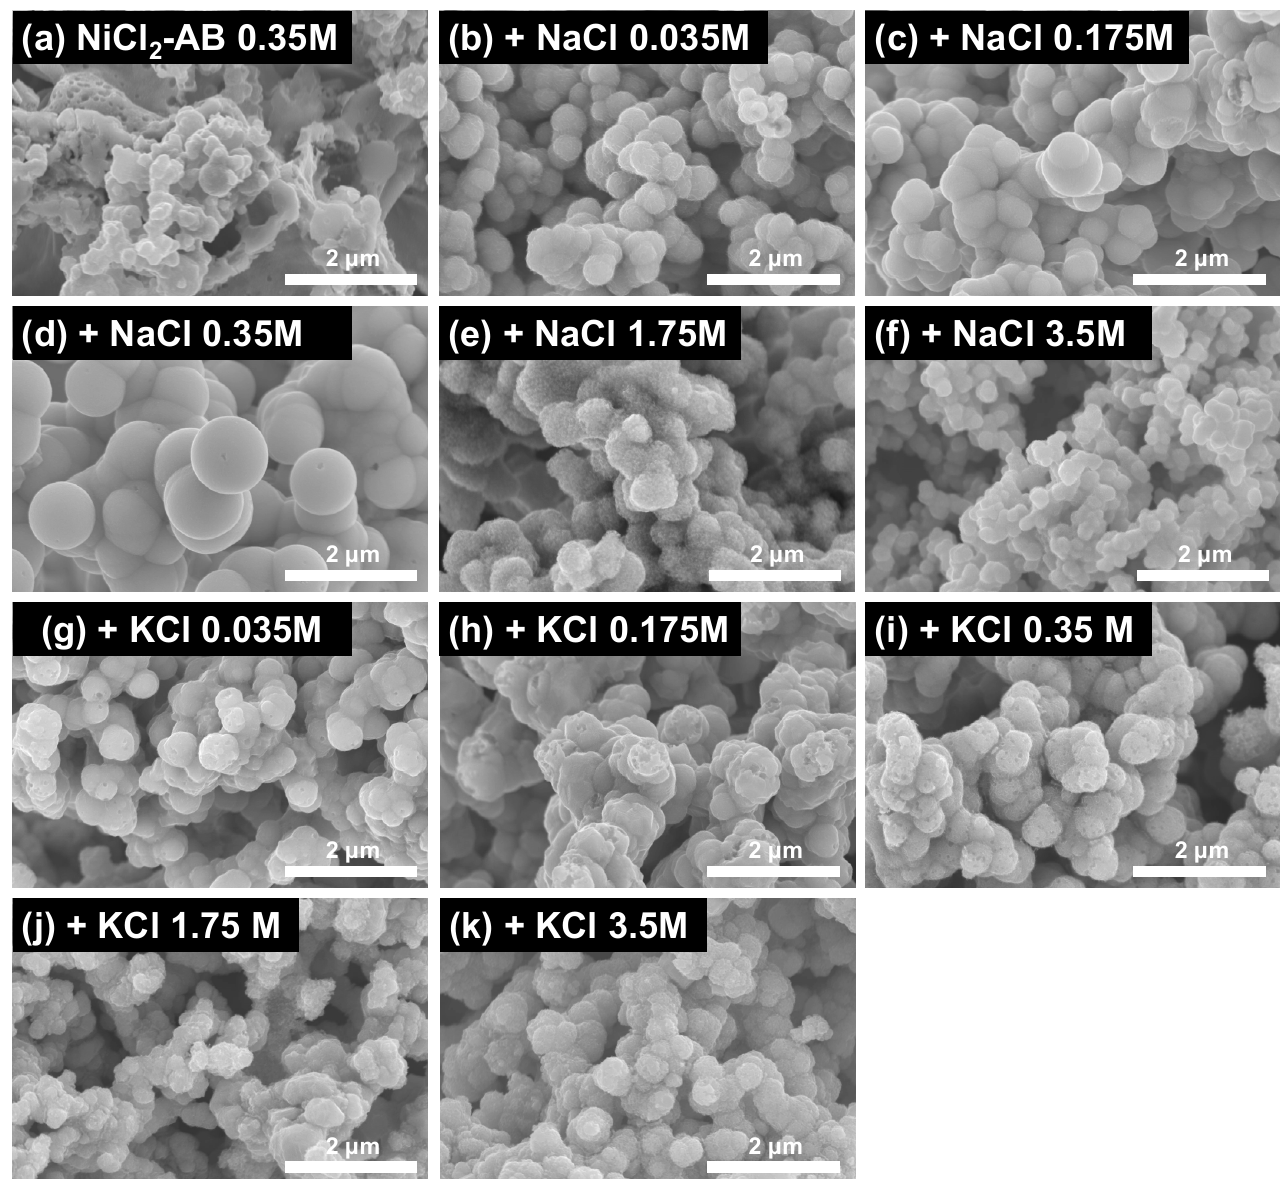
Figure 7. SEM images of Cl ion-controlled Ni nanoparticles: (a) as synthesized Ni nanoparticles without additive under 1:1 ratio of NiCl 2 and ammonia borane complex at 100 °C, (b-f) using borane-ammonia complex with NaCl and (g-k) KCl at 1:0.1, 1:0.5, 1:1. 1:5 and 1:10, respectively.